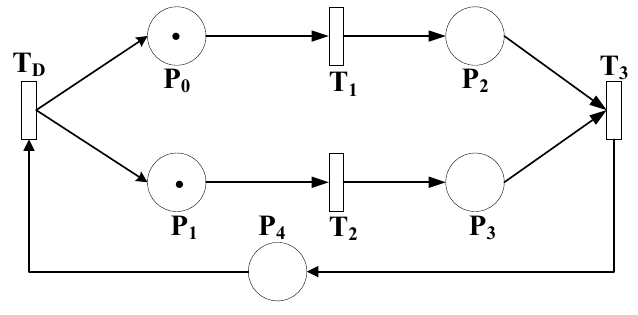
Figure 4. General Petri net